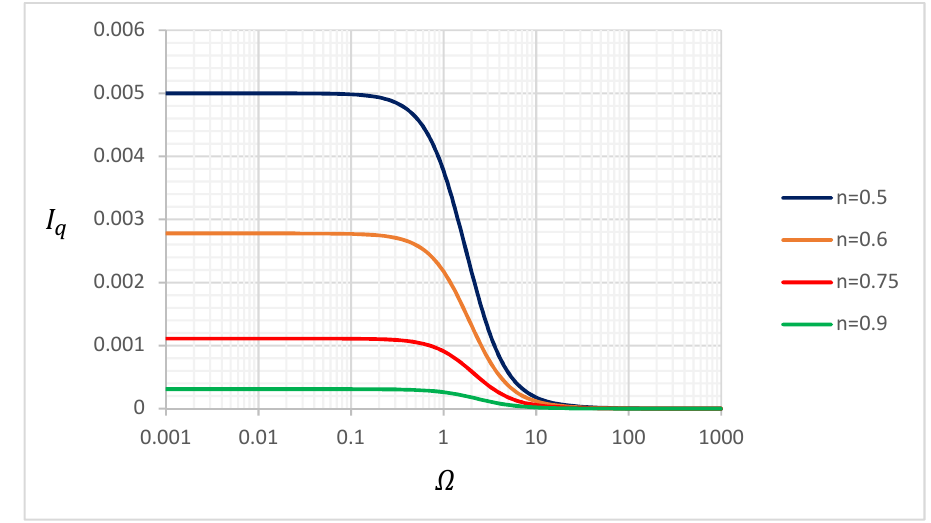
Figure 12. Dependency of the flow enhancement coefficient with dimensionless frequency and flow index for (cid:1844)(cid:1857) = 1 and (cid:2013) = 0.1 .